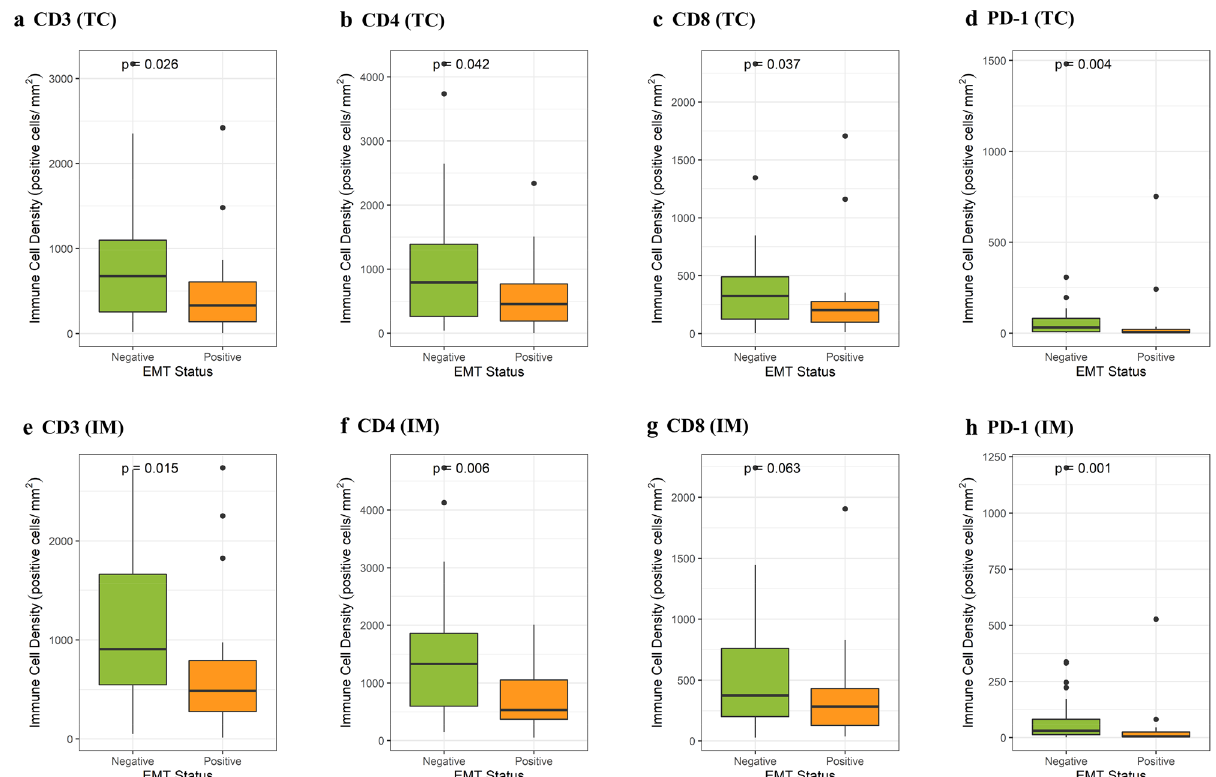
Figure 2. EMT status was associated with a low density of tumor-infiltrating immune cells (CD3, CD4, CD8) and the immune checkpoint protein PD-1 in TC ( a – d ) and IM ( e – h